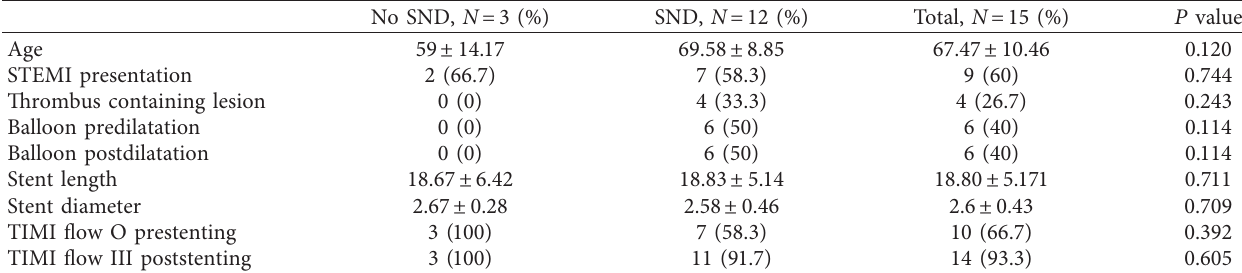
Table 5: Multivariant analysis for SND